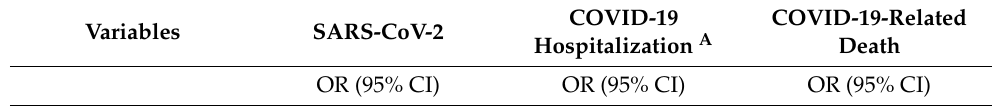
Table 3. Multivariable analysis ψ of the effectiveness of COVID-19